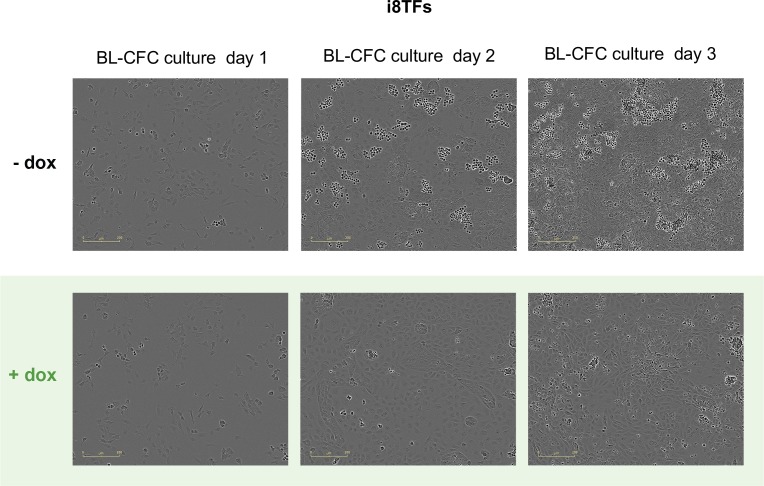
Microscopy pictures of the i8TFs BL-CFC culture after one, two and three days of BL-CFC culture in -dox and +dox conditions.The scale bar corresponds to 200 μm. See also Supplementary file 11.